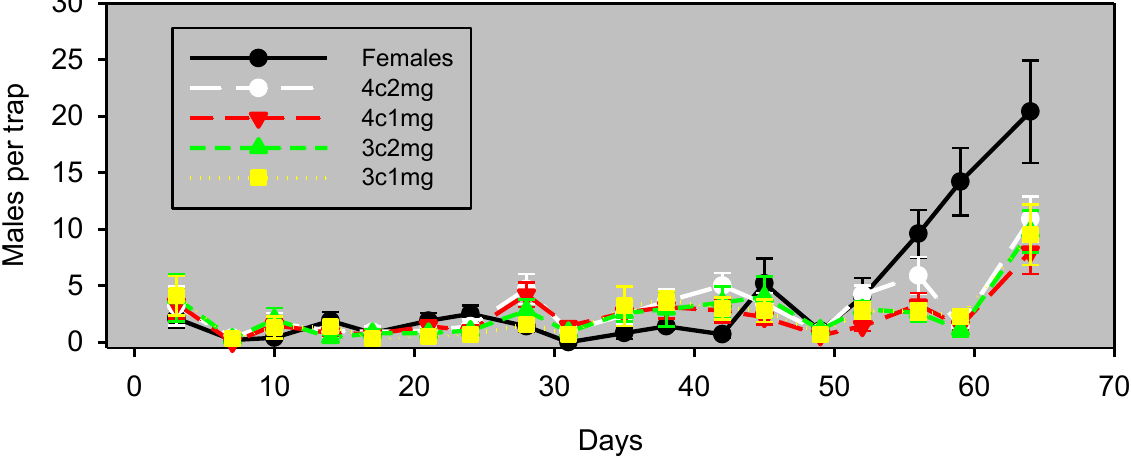
Figure 4 . Experiment 3: males captured (mean ± SE) in almonds, by monitoring the interval in wing traps baited with unmated females or artificial lures, starting April 29, 2012. Blocks were 120 m apart, and traps within blocks were 60 m apart. The lure preparation is as in Table 2.